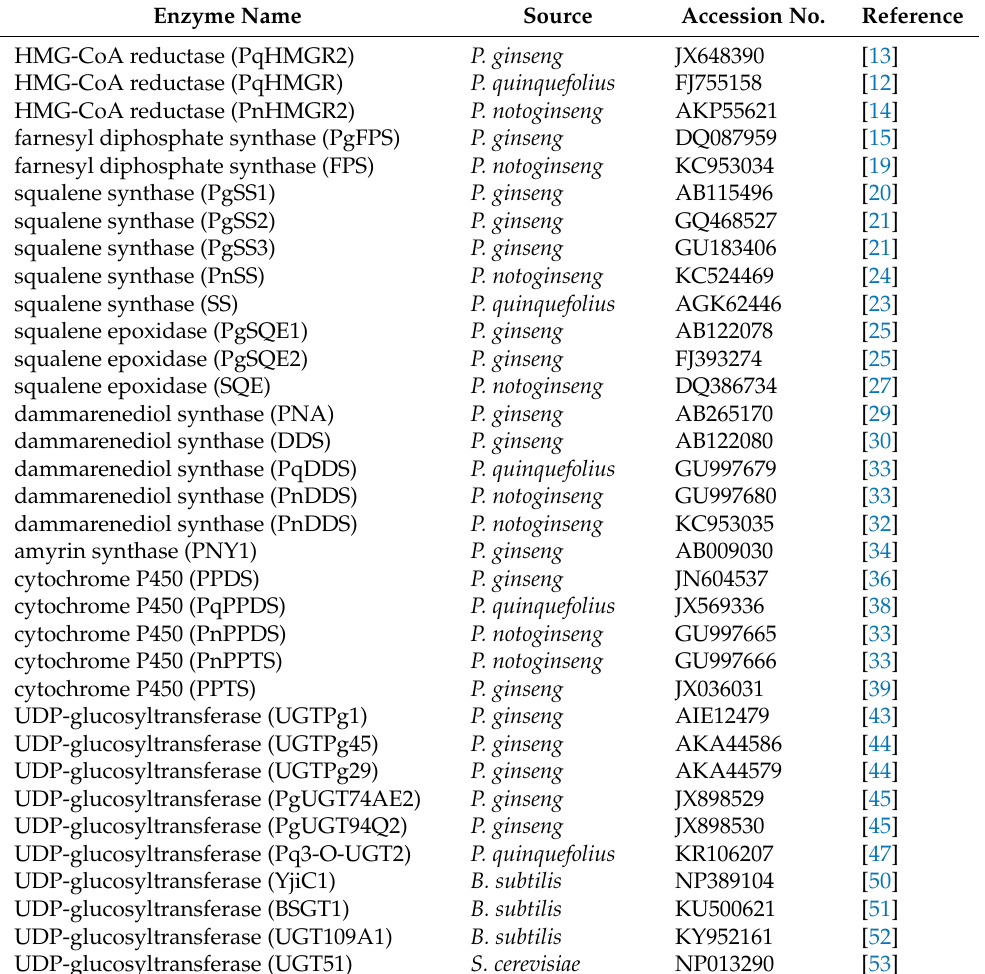
Table 1. Key enzymes involved in ginsenoside